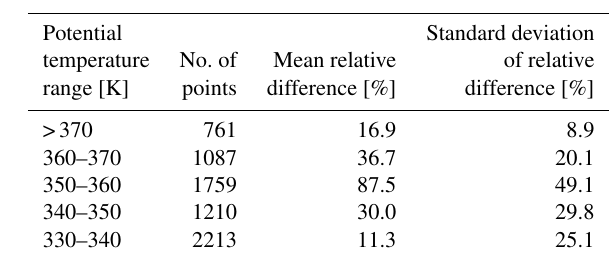
Table 3. Relative difference between ECMWF IFS data and mea- surements for different potential